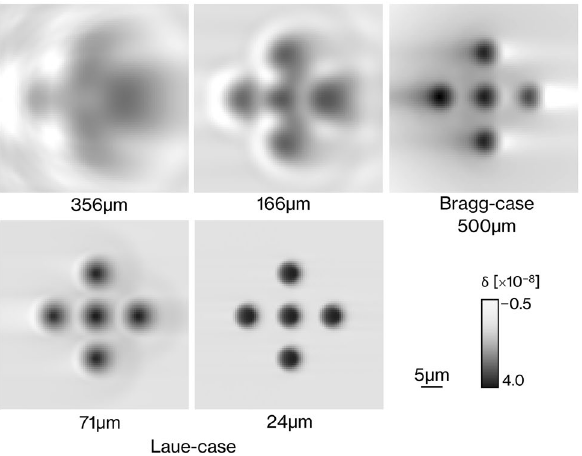
Figure 2. The reconstructed images of a numerical phantom consisting of a circle with a diameter of 5 µm, imaged by LAA with different thicknesses and BAA with 500 μm thickness.